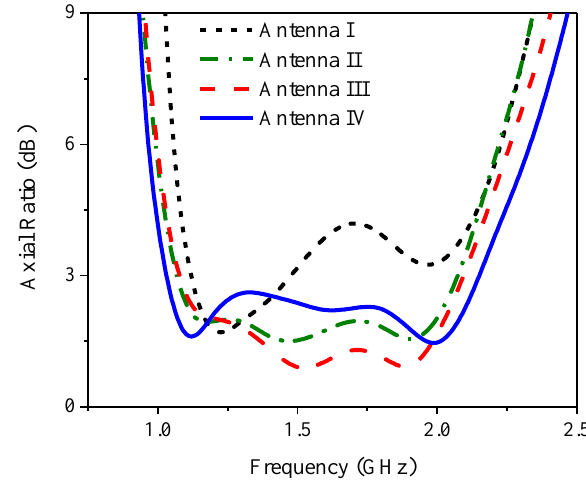
Figure 8. The simulated reflection coefficient of Antennas I, II, III and IV.